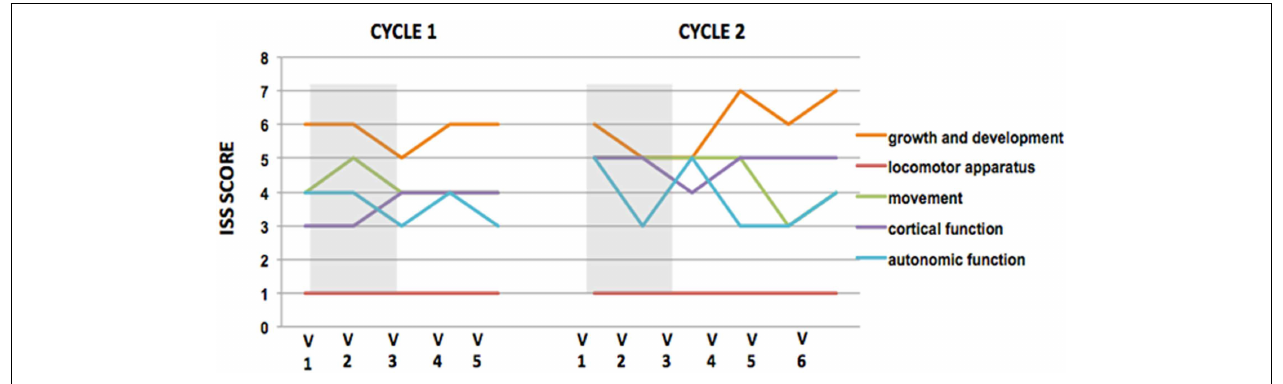
represent worst performance. In both cycles, the IGF1 treatment improved the autonomic function, while the other parameters remain unchanged or worsened between the beginning and the ending of each cycle. Note that the improvement is not maintained between